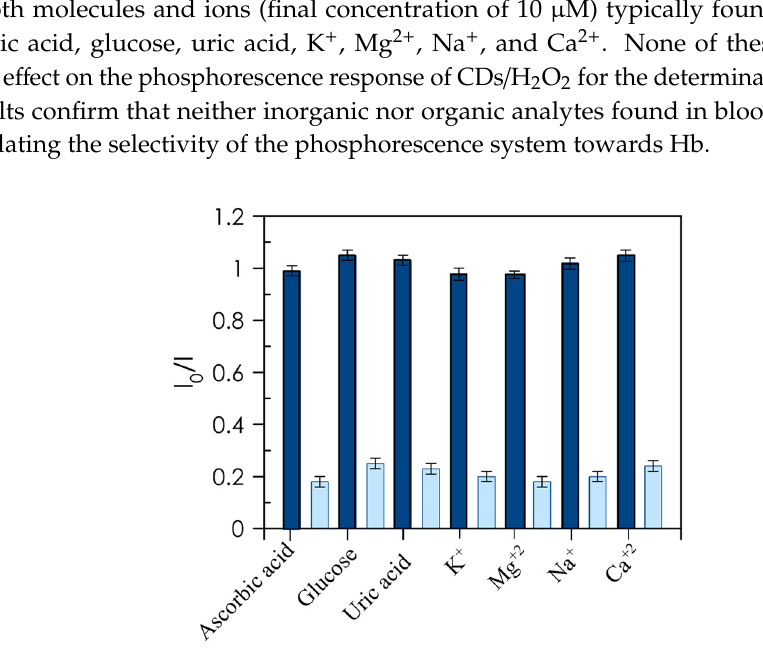
Figure 8. Selectivity of RTP assay. Response of interferents (10 μ M for ascorbic acid, glucose, and uric acid and 0.1 mM for cations) and response of Hb (100 nM) in the presence of